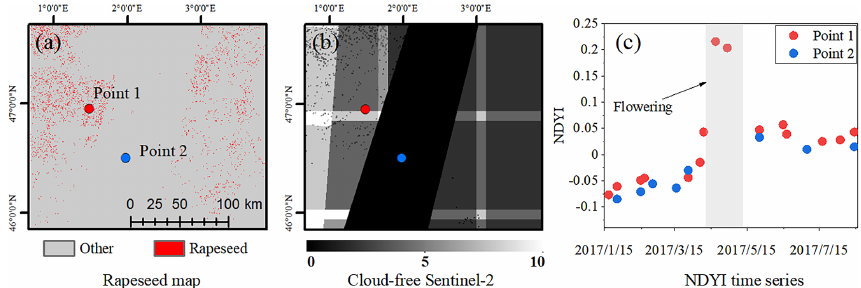
Figure 13. Example showing the effect of low-quality observations on classification accuracy. (a) Rapeseed map of an area of France in 2017 that contains an error (longitude: 2.059824 ◦ E, latitude: 46.734987 ◦ N). (b) Availability of time-series Sentinel-2 images during rapeseed flowering phases. (c) Comparison of the time series of different sites showing how the peak NDYI has been